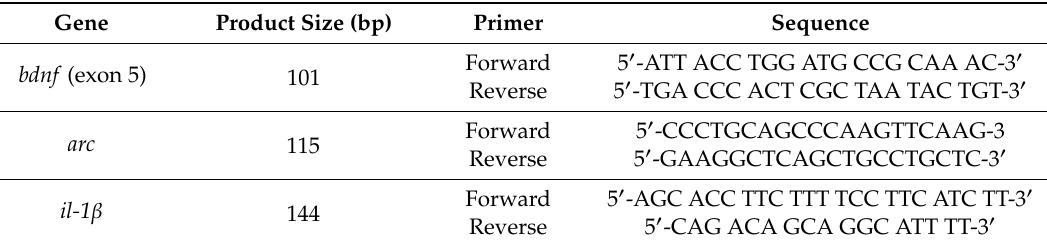
Table 2. Primers used to amplify targeted